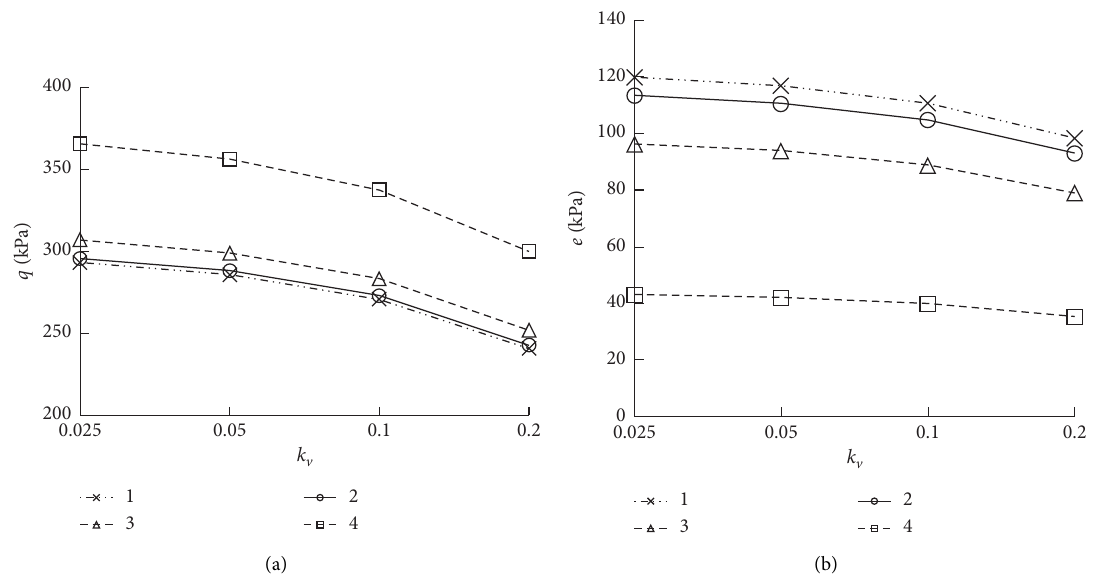
Figure 8: Influence of k k h and v on surrounding rock pressure. pressure. (b) Horizontal surrounding rock